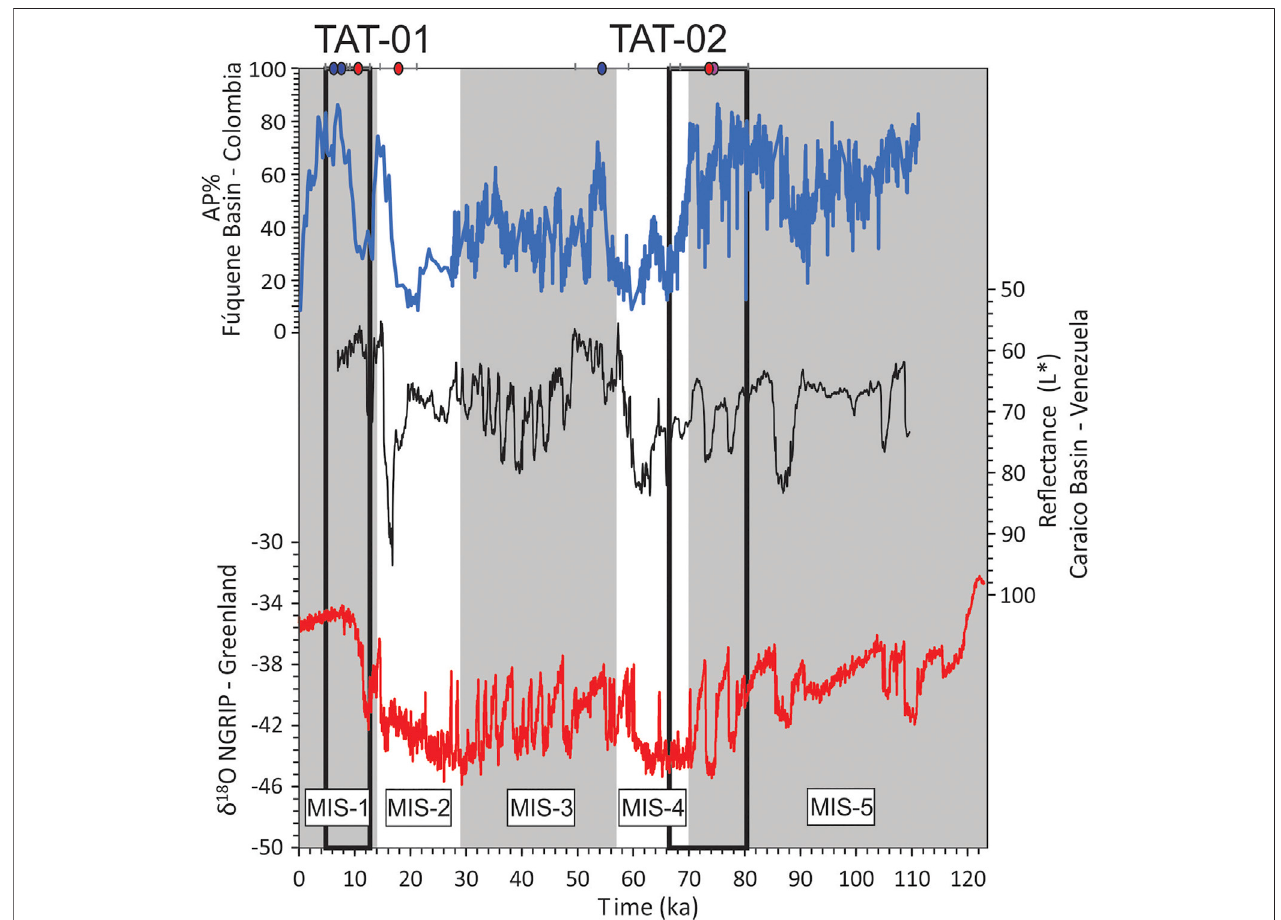
FIGURE 10 | Comparison of OSL ages with arboreal pollen percentage in the Fúquene Basin (Colombian Eastern Cordillera at 5.45 ° N Lat) (Groot et al., 2011), as an indicator of arboreal vegetation and precipitation; sediment total re fl ectance (L*) in the Cariaco Basin (Venezuela) (Deplazes et al., 2013), in which low values are indicative of dark organic, carbon-rich sediments accumulated in wet periods; and δ 18 O from NGRIP ice core (Greenland) (Rasmussen et al., 2014). Blue circles are MAM OSL ages; red circles are CAM ages; and the purple circle is the minimum age for the saturated-aliquots sample ( Table 2 ).